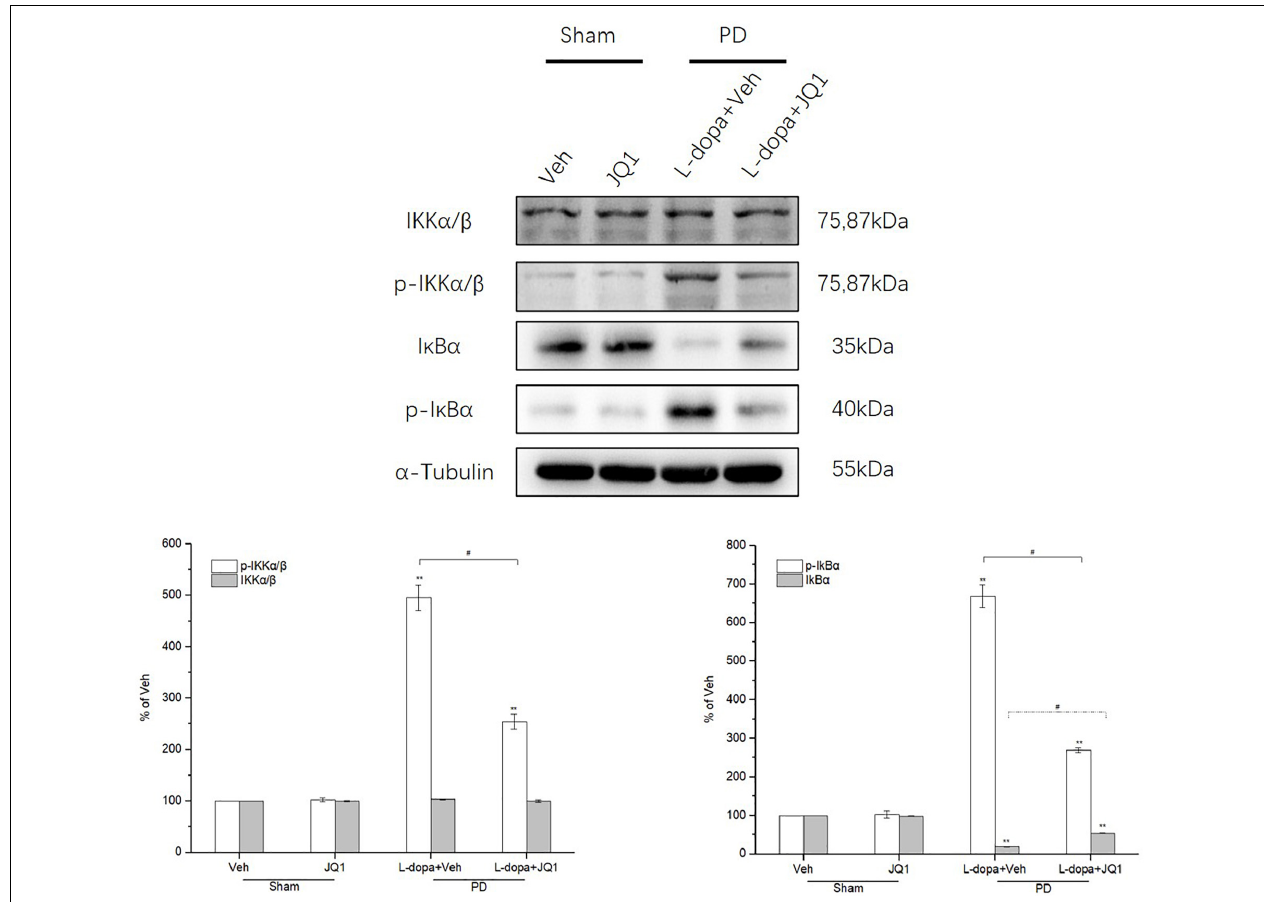
FIGURE 8 | Changes in the expression of IKK α / β , phospho-IKK α / β , I κ B α , and phospho-I κ B α in the saline- or 6-OHDA-lesioned striatum after 21 days of administration. Intermittent L-dopa stimulation induced a significant increase in the protein level of phospho-IKK α / β and phospho-I κ B α in the 6-OHDA-lesioned striatum in both L-dopa and L-dopa + JQ1 treatment groups ( p < 0.001 vs. Veh group). The protein level of phospho-IKK α / β and phospho-I κ B α in the L-dopa treatment group was much higher than that in the L-dopa + JQ1 treatment group ( p < 0.01). Notably, intermittent L-dopa stimulation induced an apparent reduction in the protein level of I κ B α in both the L-dopa and L-dopa + JQ1 treatment groups ( p < 0.001 vs. Veh group). The protein level of I κ B α in the L-dopa treatment group was statistically lower than that in the L-dopa + JQ1 treatment group ( p < 0.01). JQ1 barely affected the expression of phospho-IKK α / β , phospho-I κ B α , and I κ B α in the saline-lesioned striatum of JQ1 treatment group. The IKK α / β protein level remained unchanged among the four treatment groups. The protein levels expressed relative to α -tubulin levels. The data are expressed in terms of mean ± SD and as a percentage of the Veh group, ** p < 0.001 vs. Veh group, # p < 0.01 vs. L-dopa treatment group ( n = 3 per